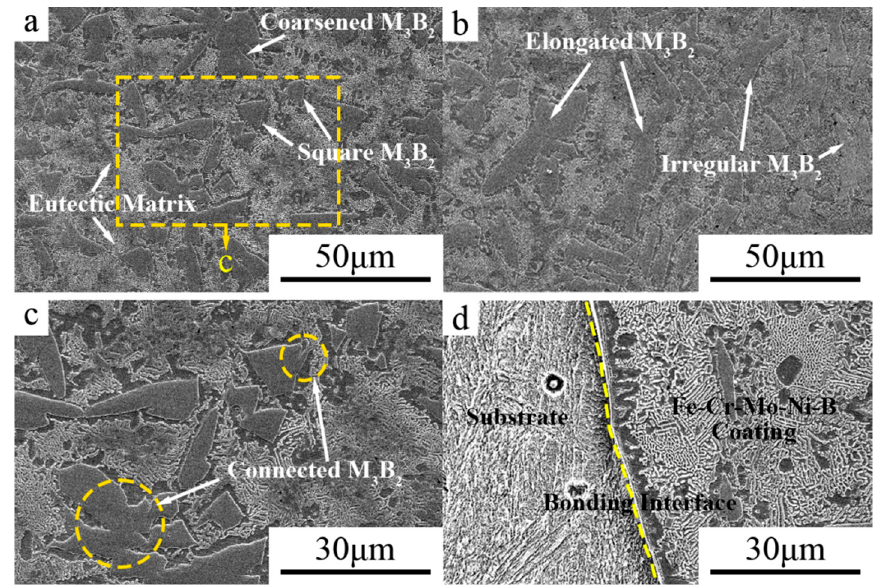
Figure 6. OM image of the Fe–Cr–Mo–Ni–B coating: ( a ) block morphology; ( b ) strip morphology; ( c ) high magnification of block morphology; ( d ) fusion area.